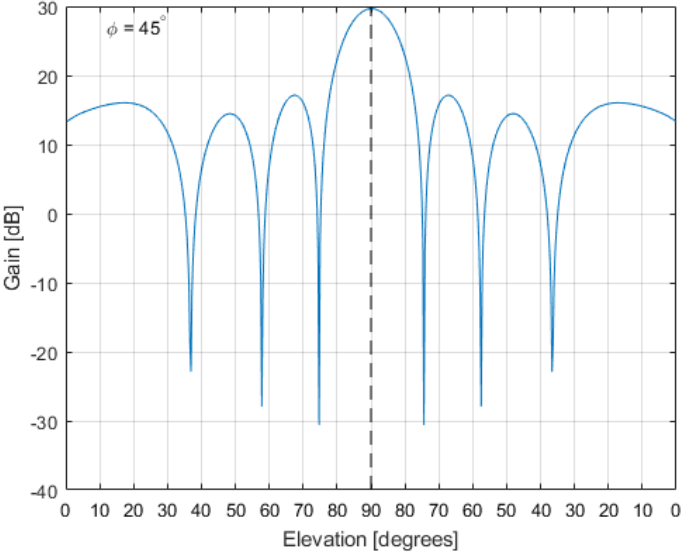
Figure 7. Vertical cut at 45 ◦ azimuth of the unsteered beam pattern for the LOFAR